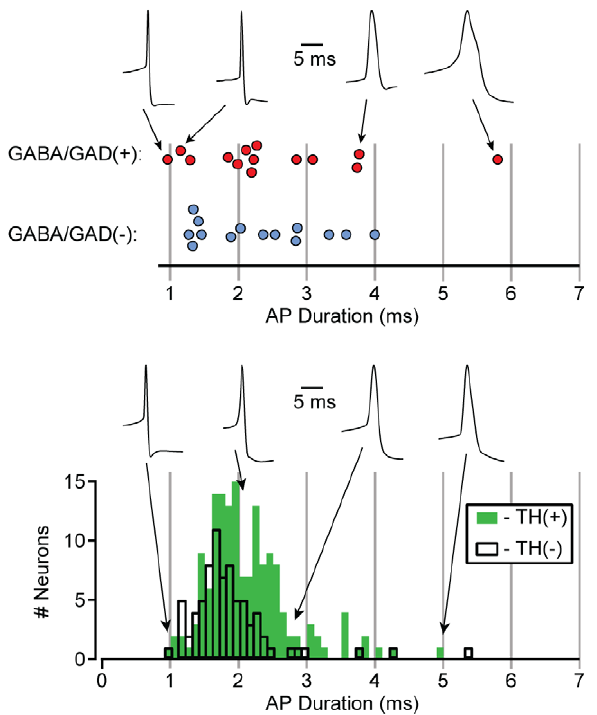
Figure 7. The distribution of action potential durations in VTA GABA neurons overlaps with that of cytochemically confirmed dopamine neurons. Neurons recorded on the same day were identified post hoc as GABA/GAD( + ) or GABA/GAD( 2 ), and their AP duration distributions are overlapping (top). This is consistent with data from TH( + ) and TH( 2 ) neurons where the range AP durations of TH( 2 ) neurons spans the range for TH( + ) neurons (bottom).